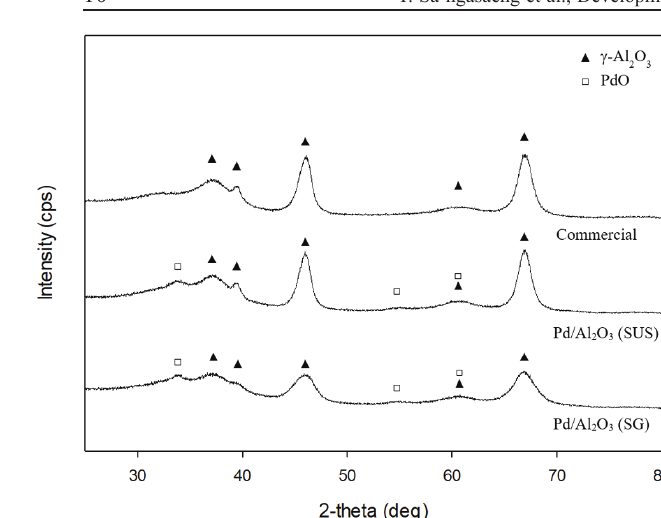
Fig. 6 – XRD patterns of commercial Al